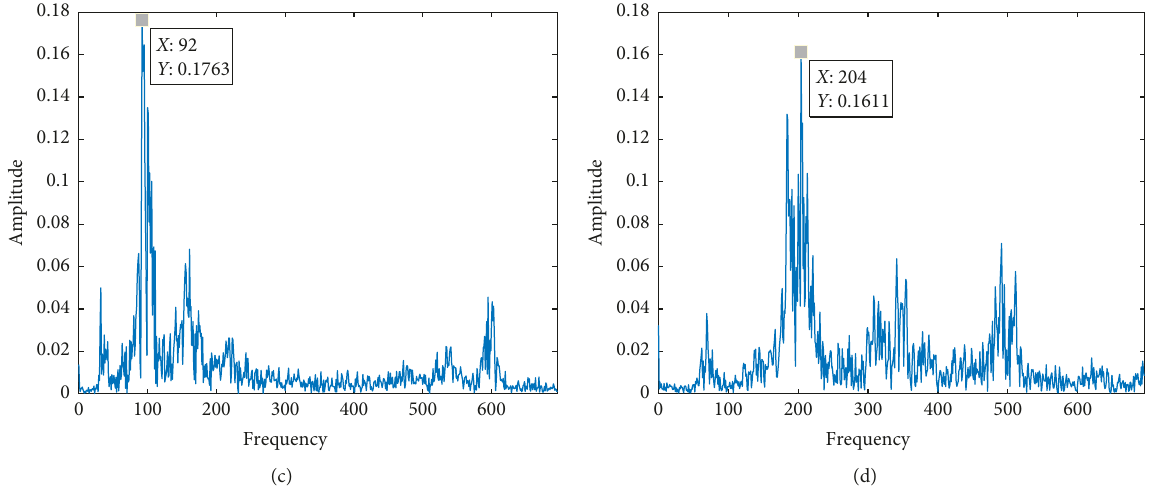
Figure 11: Representative amplitude-frequency curves of